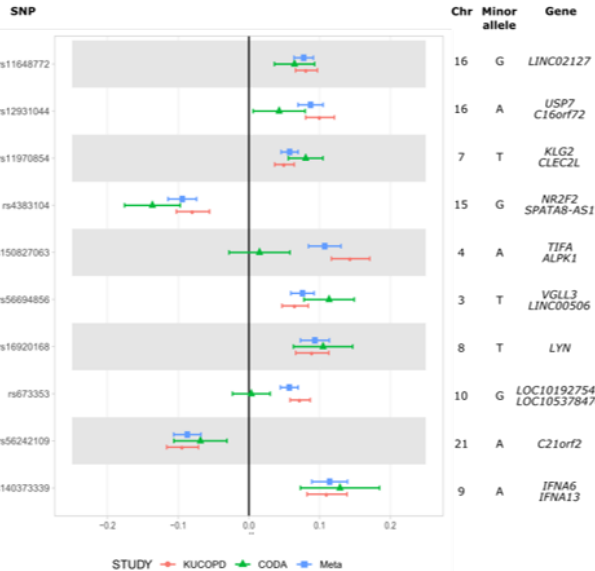
Figure 3. Forest plot for the top ten SNPs associated with airway wall thickness.